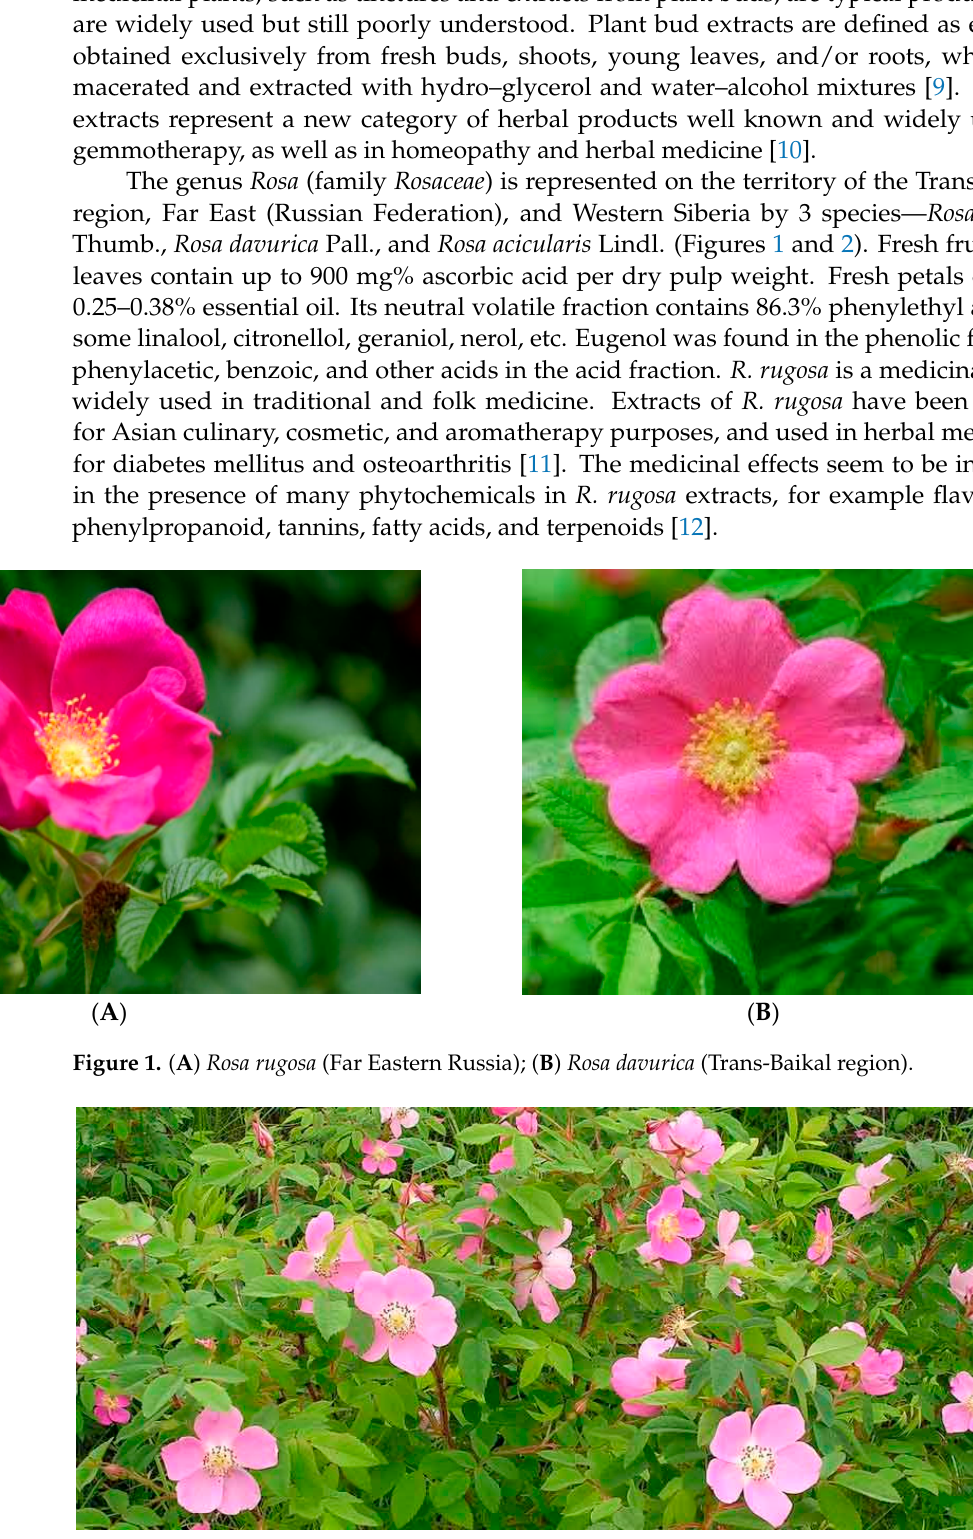
Figure 2. Rosa acicularis ( Western Siberia).